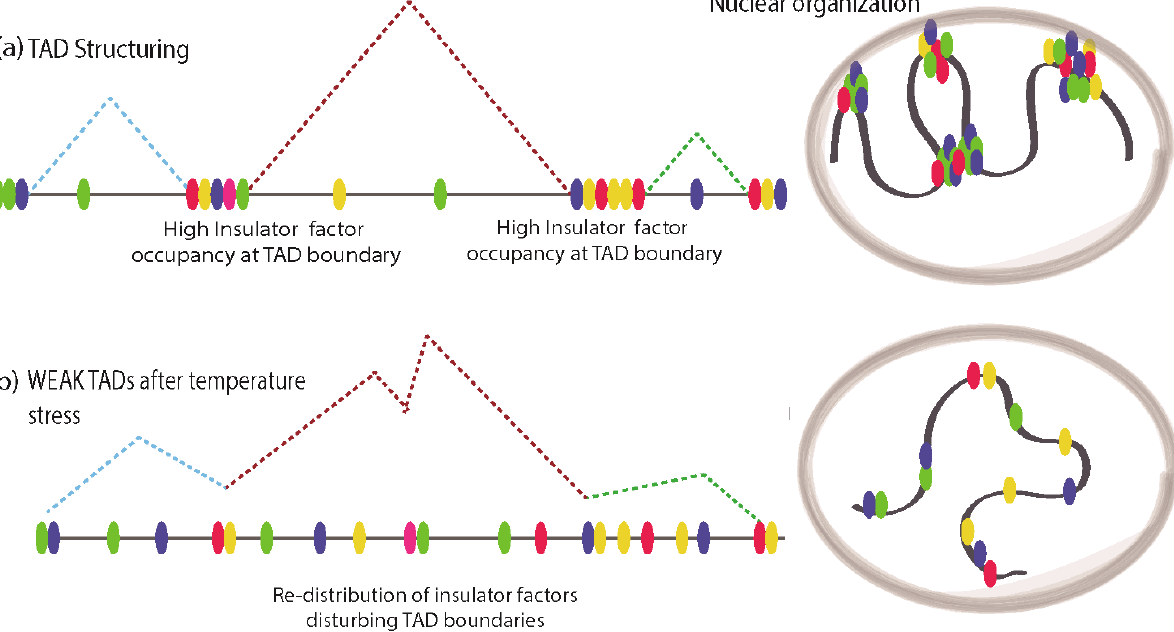
Figure 3. Stress induces redistribution of insulator factors and reconfiguration of chromatin structure. ( a ) Normal TAD is structured by architectural/insulator proteins clustered around their boundaries, maintaining the Megabase scale chromatin structuring, while intra-TAD looping in mediated by discrete motifs for insulator factor binding; ( b ) Under temperature stress, TAD boundaries get weakened due to re-distribution of insulator factors to intra-TAD